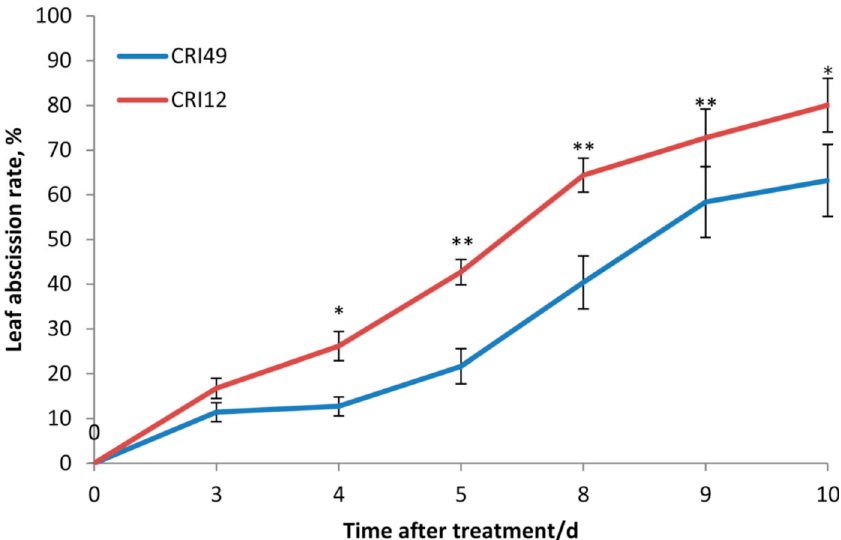
Figure 4. Effects of TDZ on leaf abscission rate between CRI 49 and CRI 12 at the seedling stage. * and ** denote significance at the 0.05 and 0.01 levels,